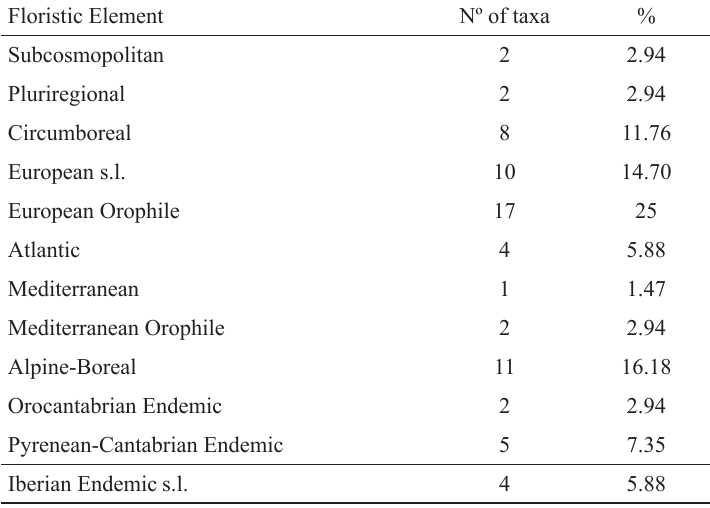
Table 3. Chorotype of taxa participating in High Campoese finely-toothed willow